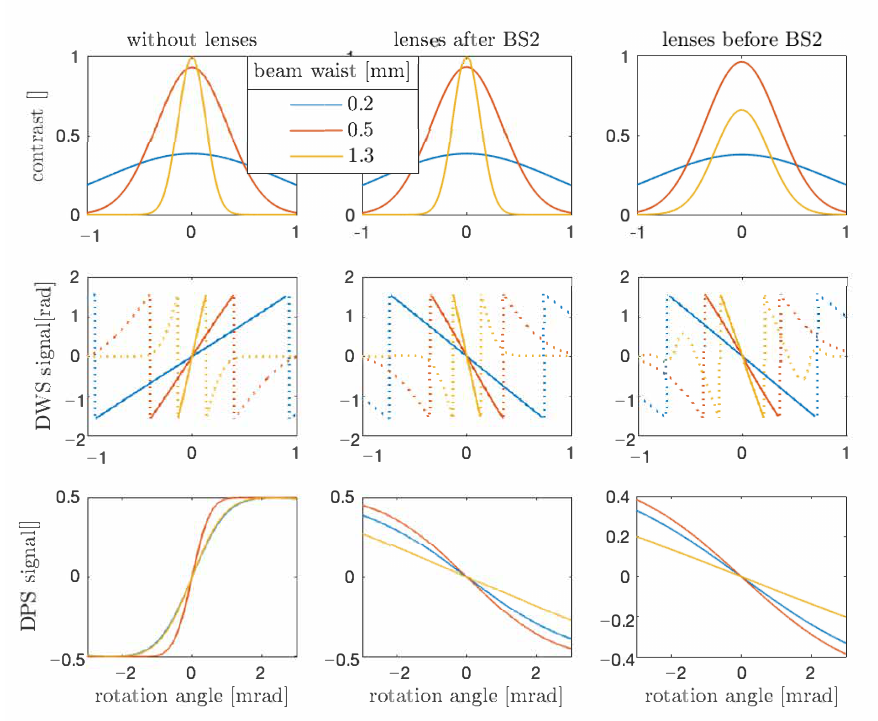
Figure 3. The impact of lenses and also the beam waist size on the interferometric signals. The contrast and the slope of the DWS signal increase by increasing the waist size, whereas the slope of DPS signal depends on the beam spot size on the photo diode. Furthermore, implementing lenses in the setup reduces the beam walk on the photo diode, which results in flatter slope of the DPS signal that allows sensing a wider rotation range. The dotted trajectory in the DWS signal cannot be used for rotation